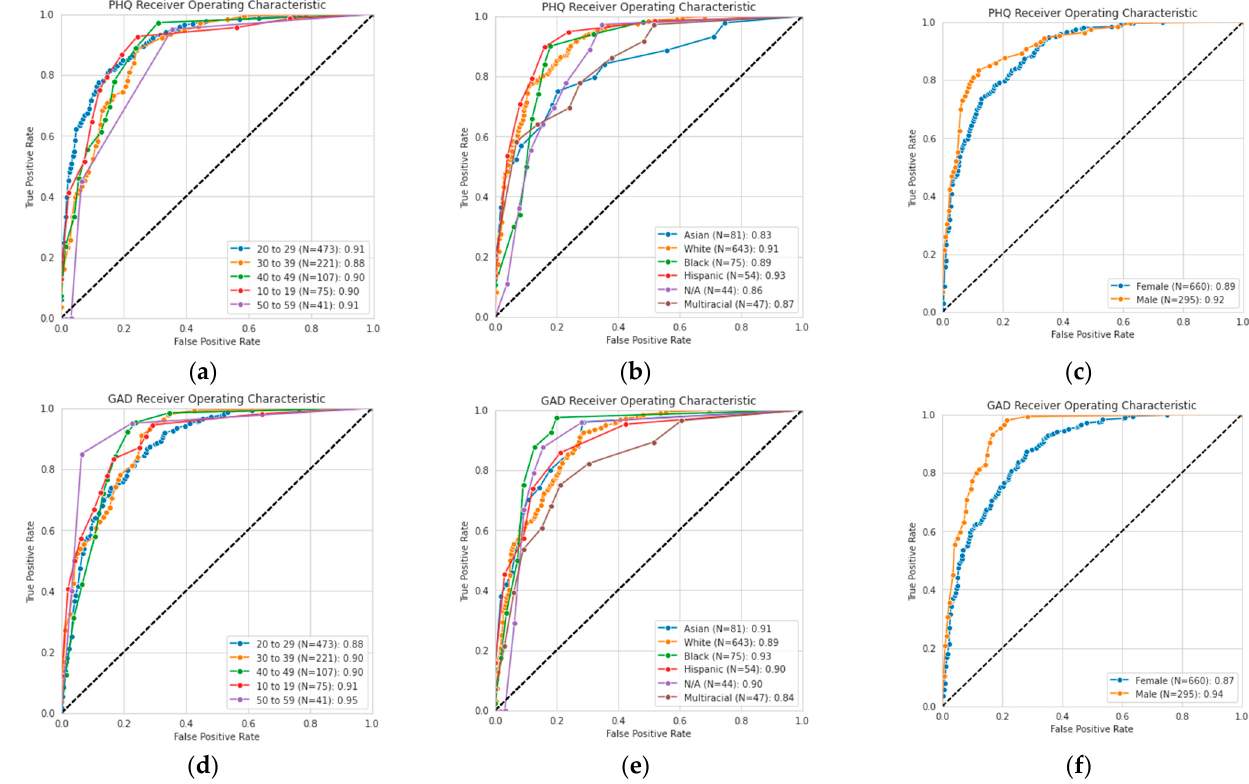
Figure 7. Receiver operating characteristic (ROC) curves for self-reported ( a ) age, ( b ) ethnicity, and ( c ) gender for PHQ-V predictions, and ( d ) age, ( e ) ethnicity, and ( f ) gender for GAD-V predictions.